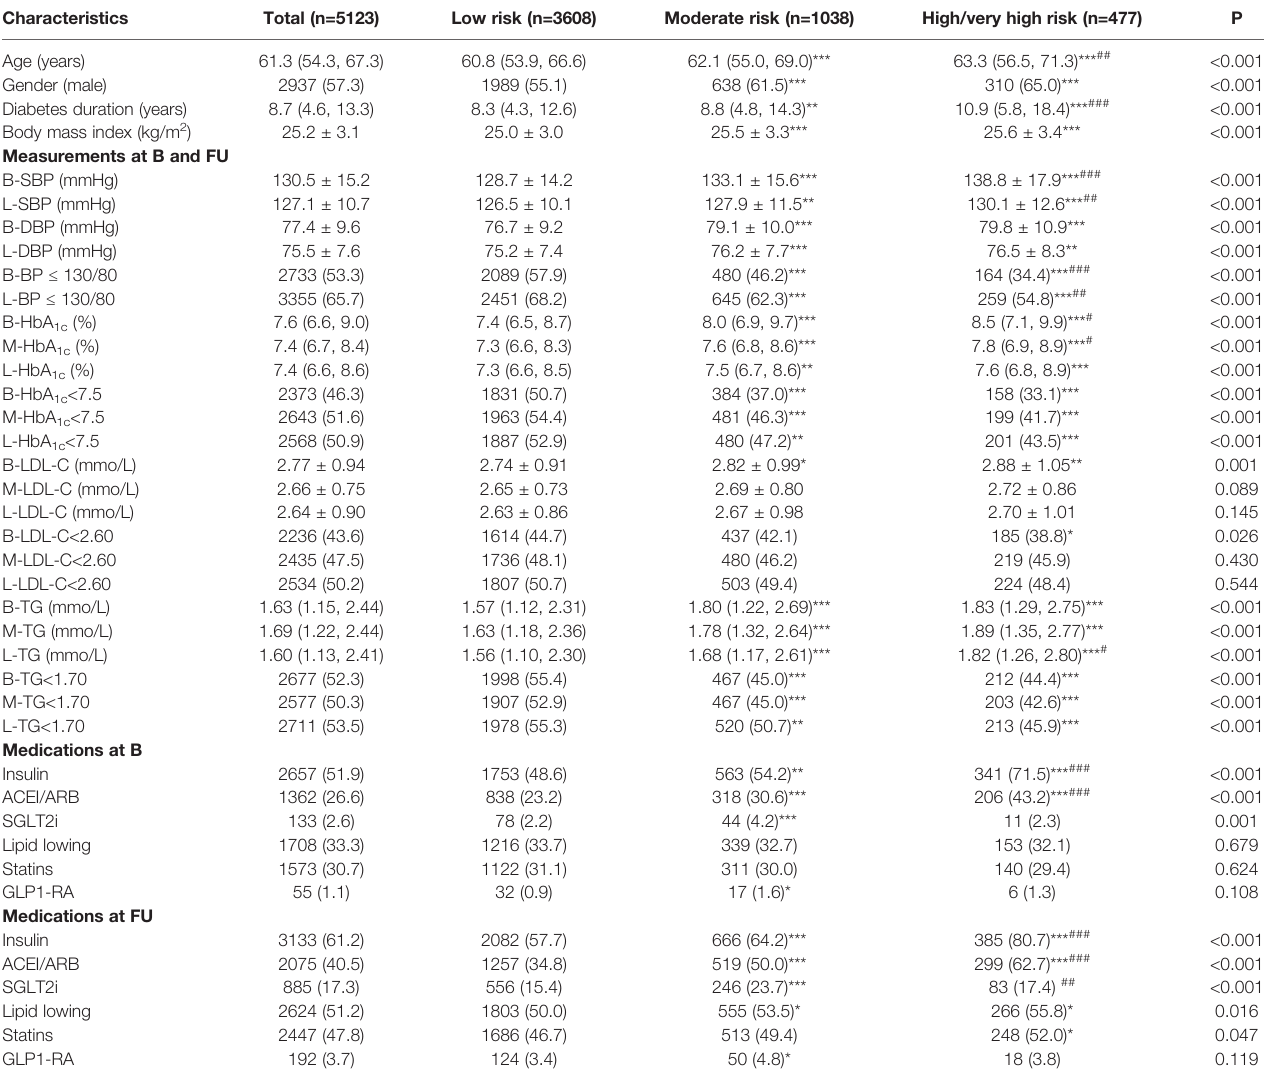
TABLE 2 | Characteristics of study population by risk categories for CKD outcome.